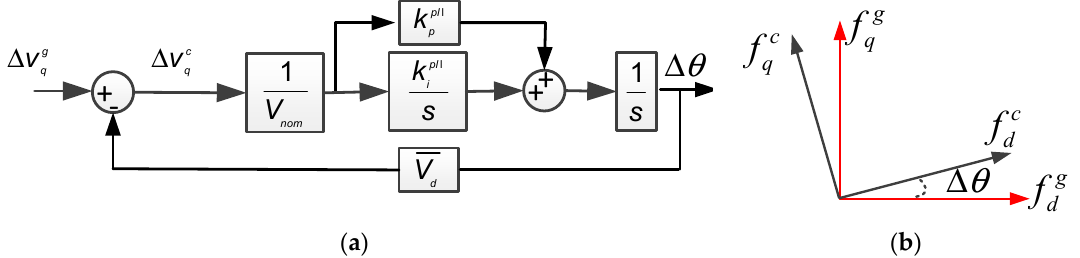
Figure 4. Synchronous reference frame phase-locked loop (SRF-PLL), ( a ) small signal model of PLL, ( b ) controller ( f dqc ) and system ( f dqg ) frames under small-signal perturbations because of the PLL dynamics.